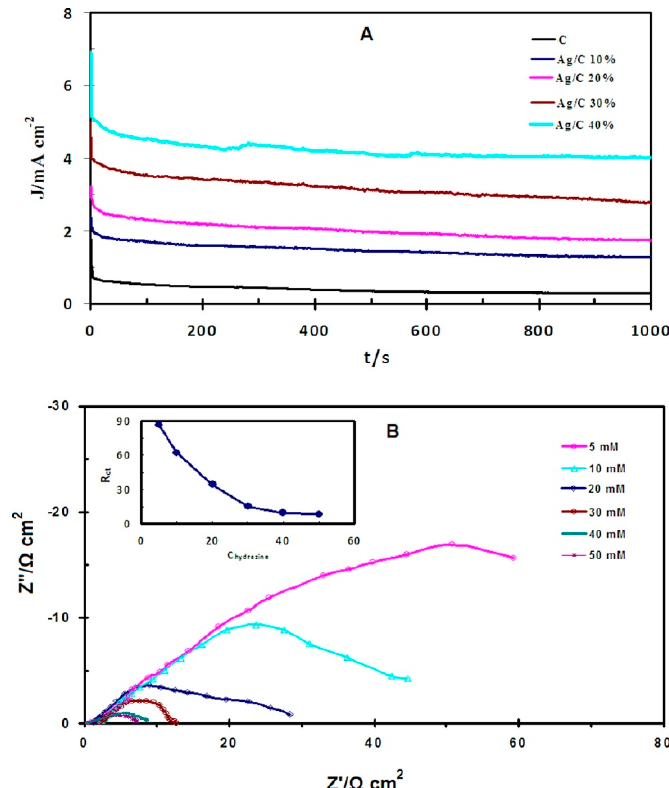
Figure 9. ( A ) Chronoamperometry curves of Ag/C catalysts with different Ag content in 0.1 M K 2 SO 4 + 10 mM N 2 H 4 solution at 0.2 V. ( B ) Nyquist plots recorded at 0.2 V for the Ag/C 40Wt% catalyst in 0.1 M K 2 SO 4 containing various hydrazine concentrations. Inset of ( B ): Plot of the charge transfer resistance (R ct ) versus hydrazine concentrations (CN 2 H 4 ). (reprint from [104] with permission from Elsevier. Copyright